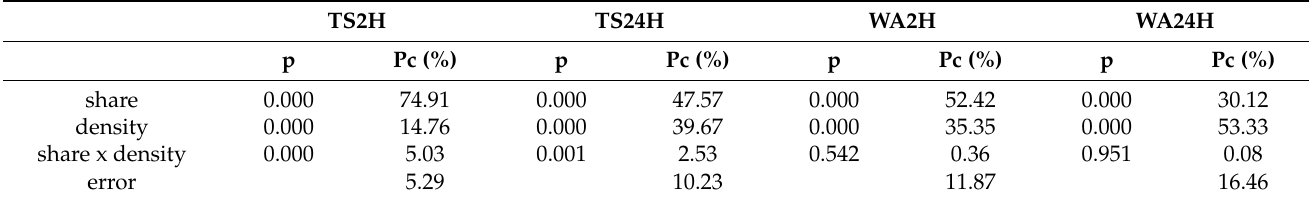
Table 6. Statistical significance of factor influences on physical properties of particleboards.